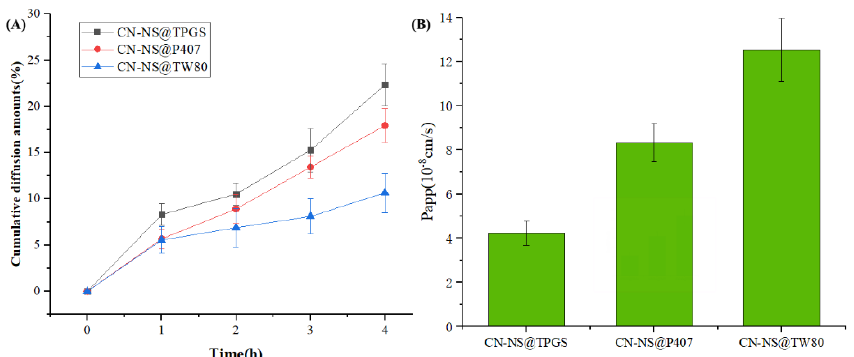
Figure 4. The cumulative diffusion amount (%) ( A ) and permeability coefficient ( B ) of the CN-NS incubated with mucin.